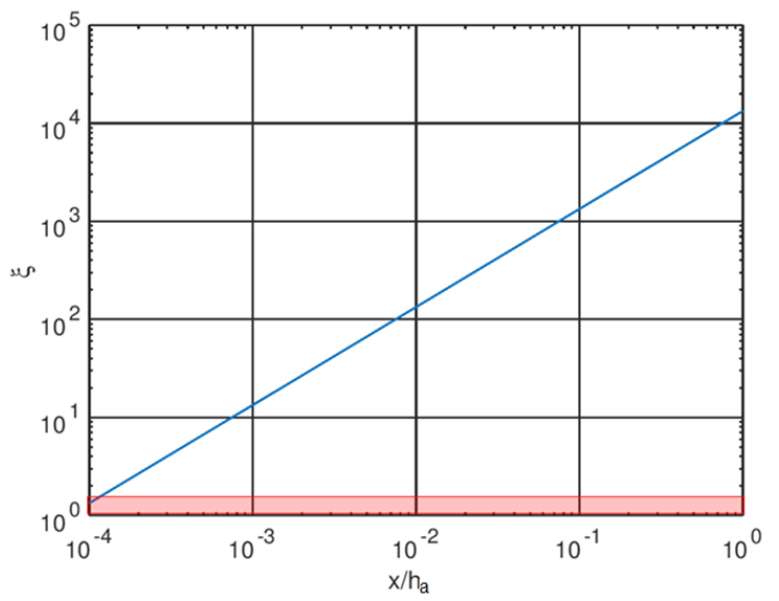
Figure 6. Evolution of 𝜉 in the function of the distance from the plate edge being normalized by film thickness. The red rectangle represents the domain of validity of the close-edge approximated solution.